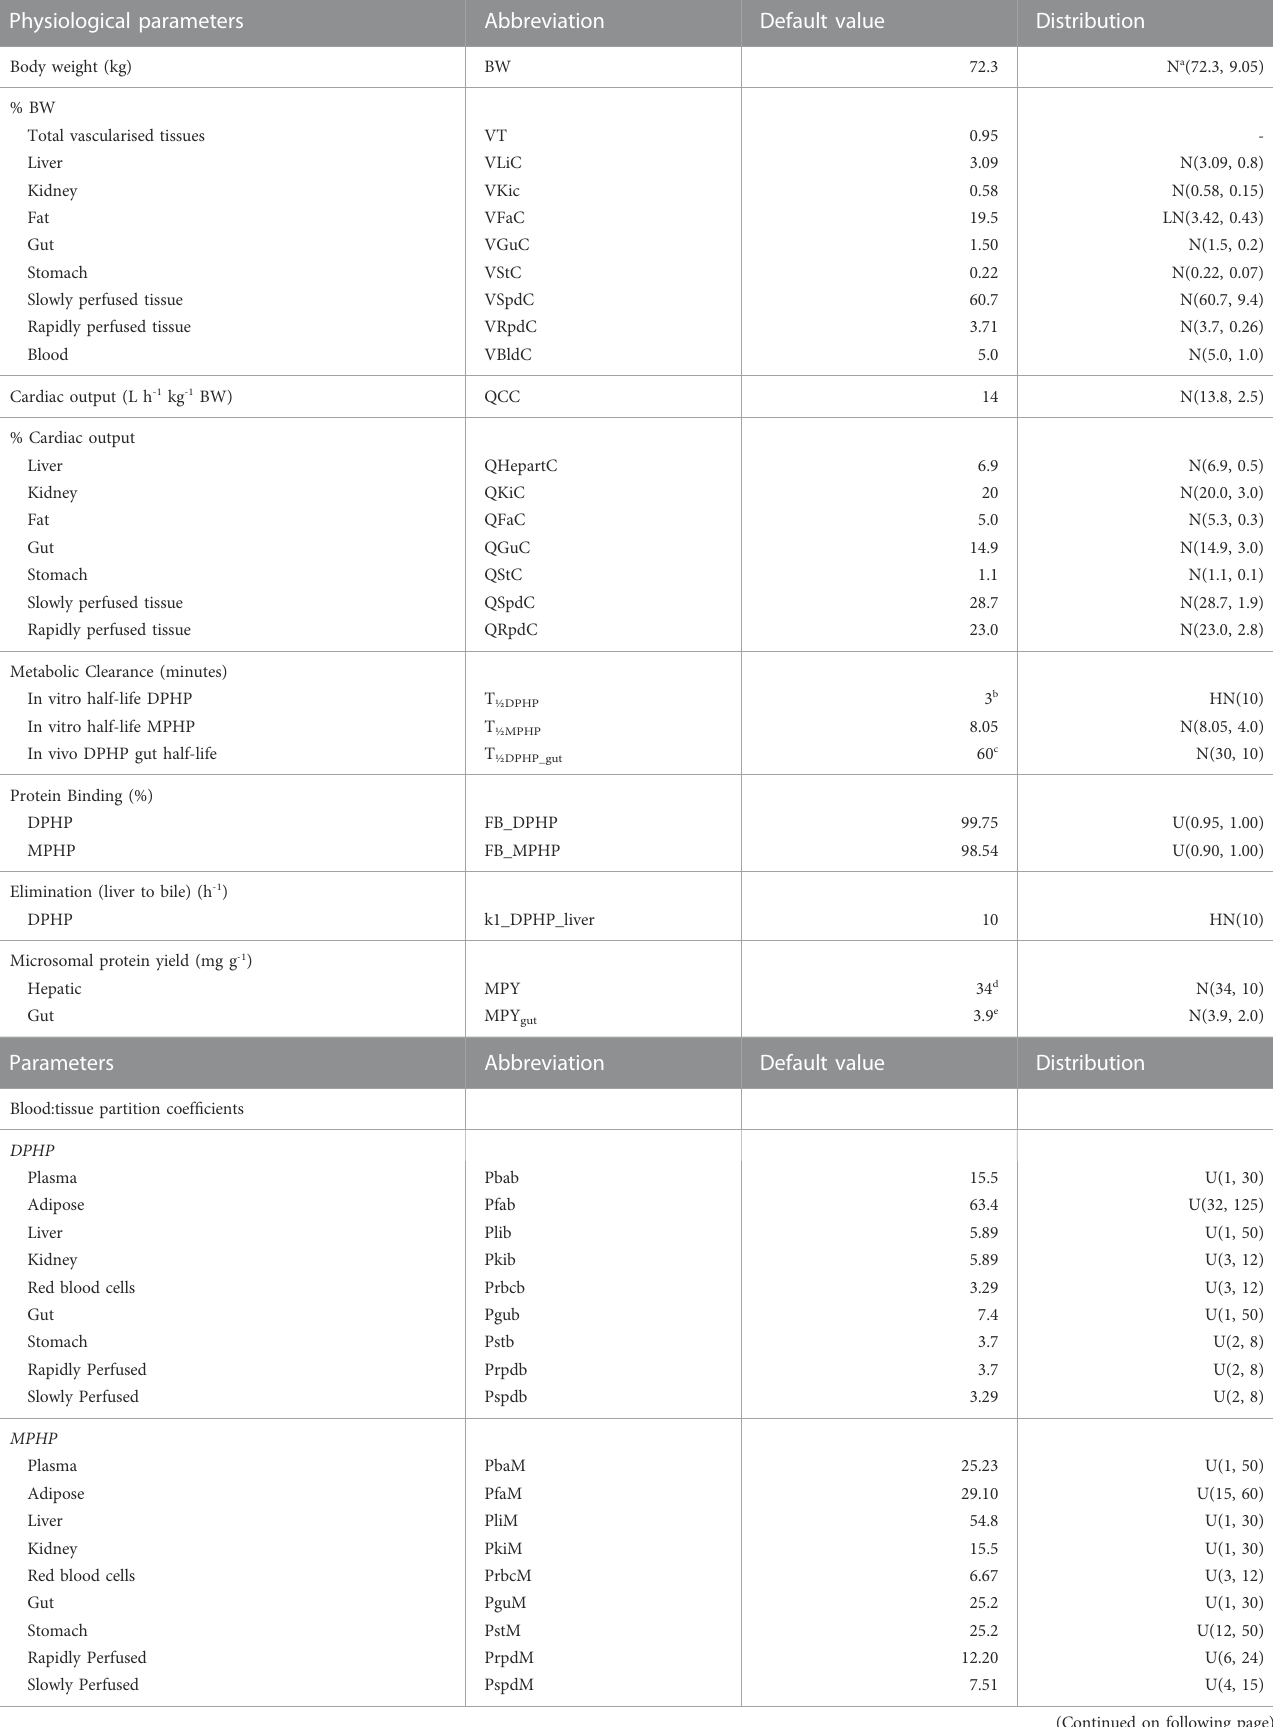
TABLE 3 Physiological and kinetic default values used in PBPK model and probability distributions applied for uncertainty and sensitivity